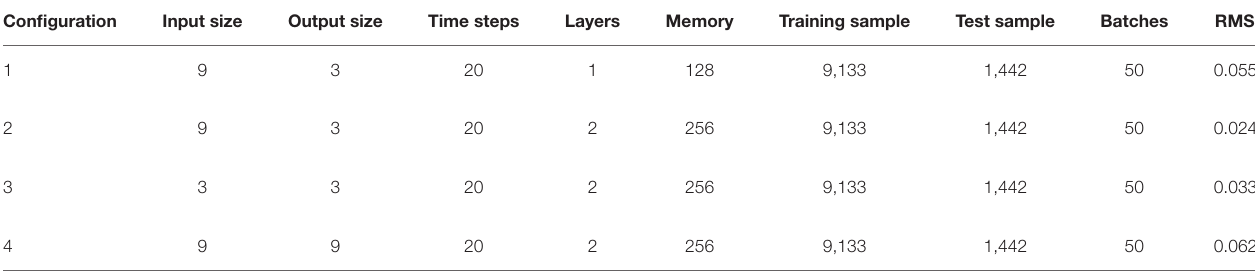
TABLE 1 | The result obtained from different configurations of the DNN. Configuration